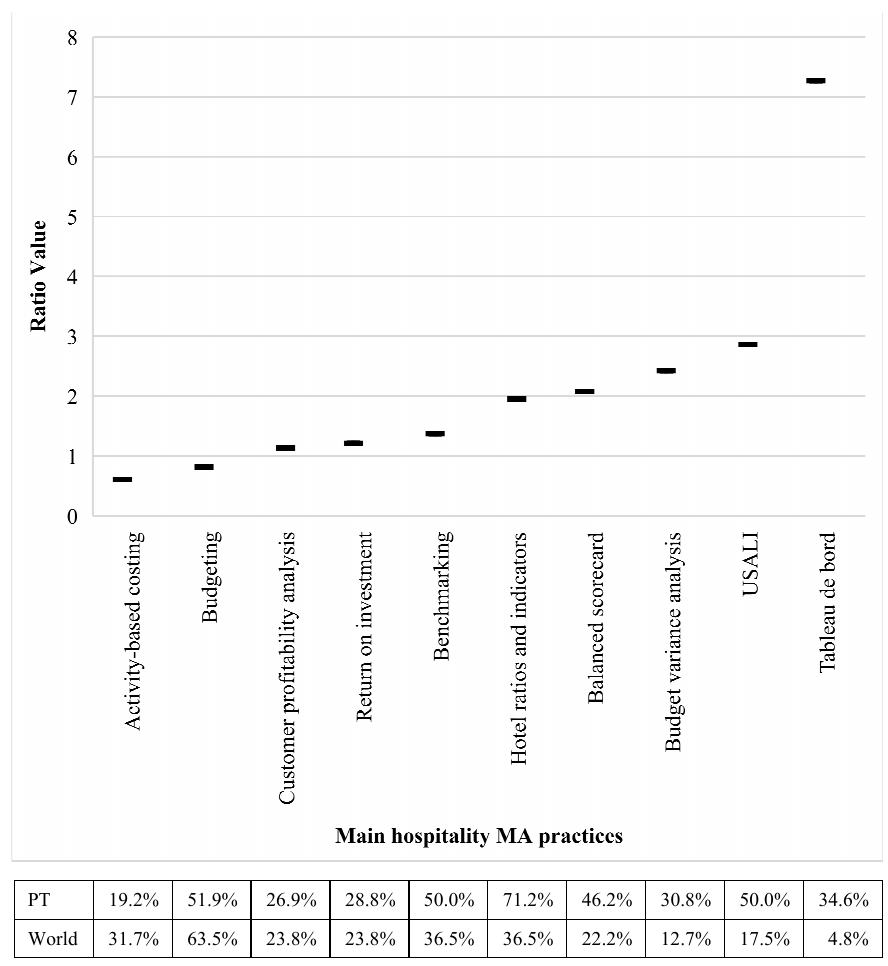
Figure 12. Ratio between the percentage of use of the main hospitality MA practices: Portugal vs. the world.